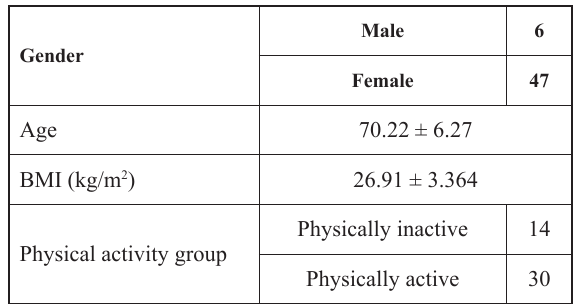
Table 1. Characteristics of research